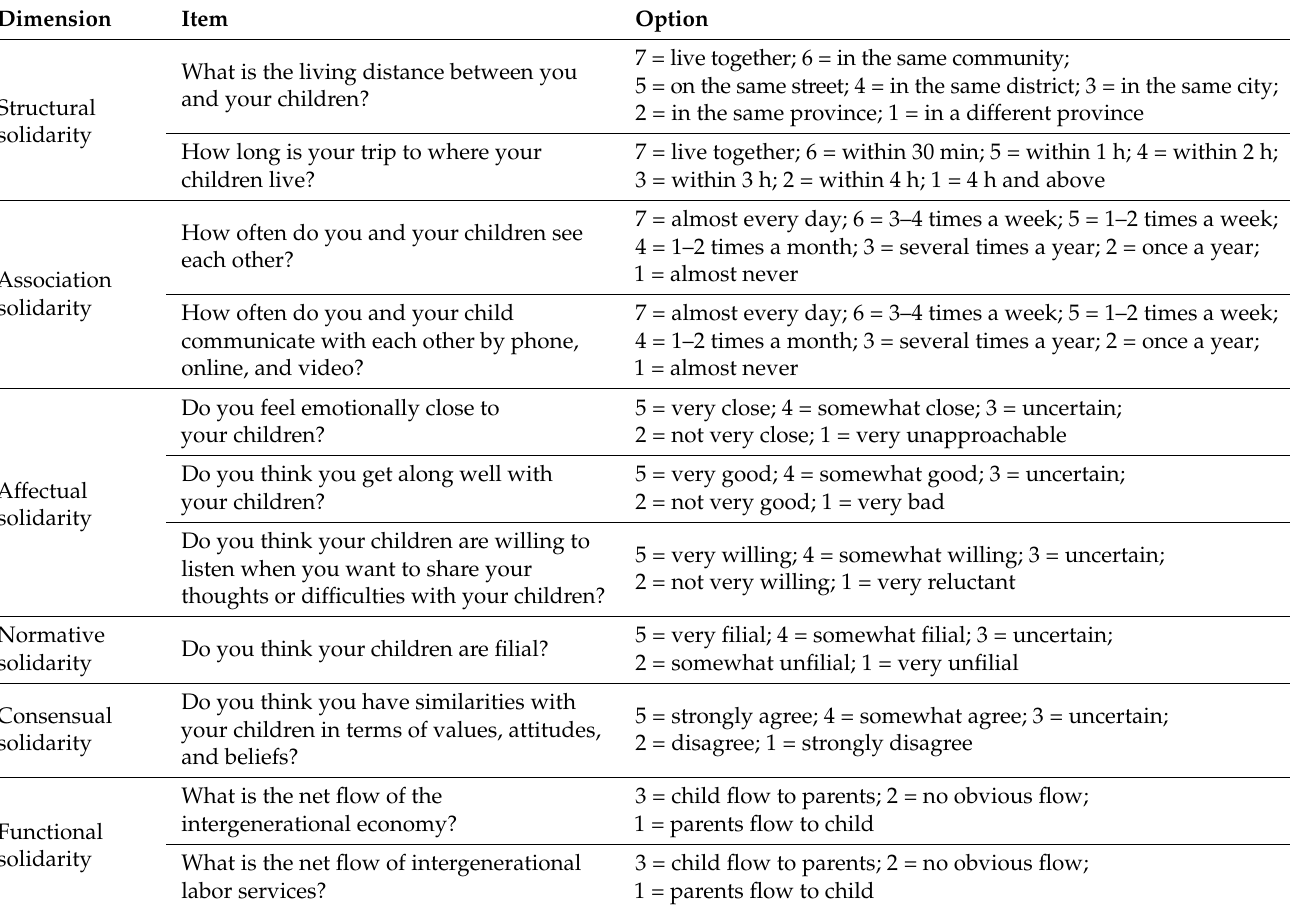
Table 2. Measurement indicators of intergenerational relations under the intergenerational solidar- ity